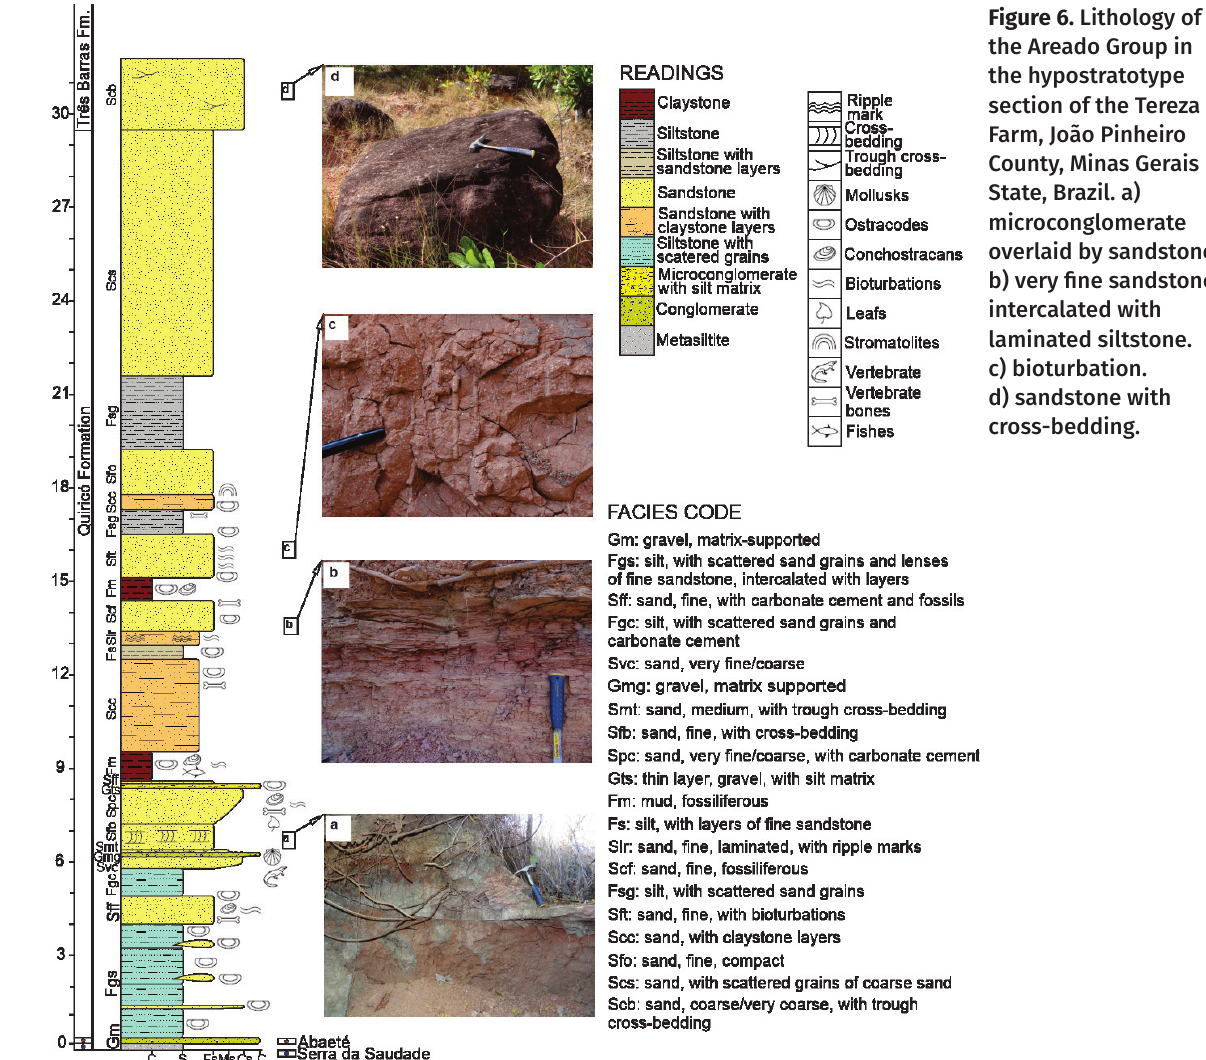
Figure 6. Lithology